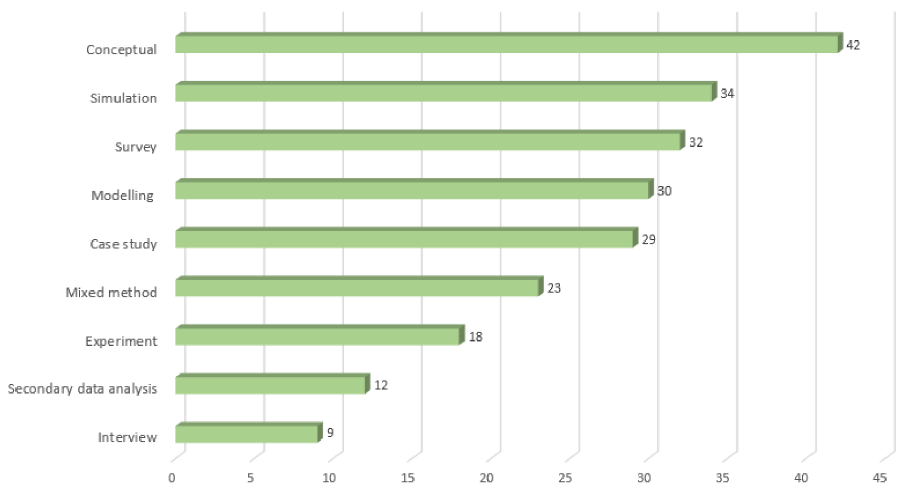
Figure 5. Research method used in primary studies.